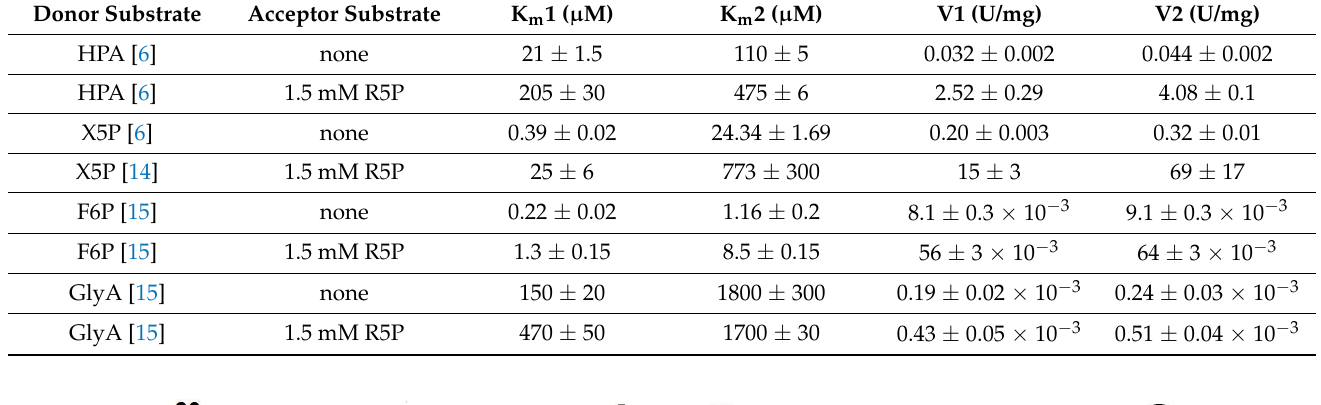
Table 2. Kinetic parameters of holoTK in one-substrate and two-substrate reactions.